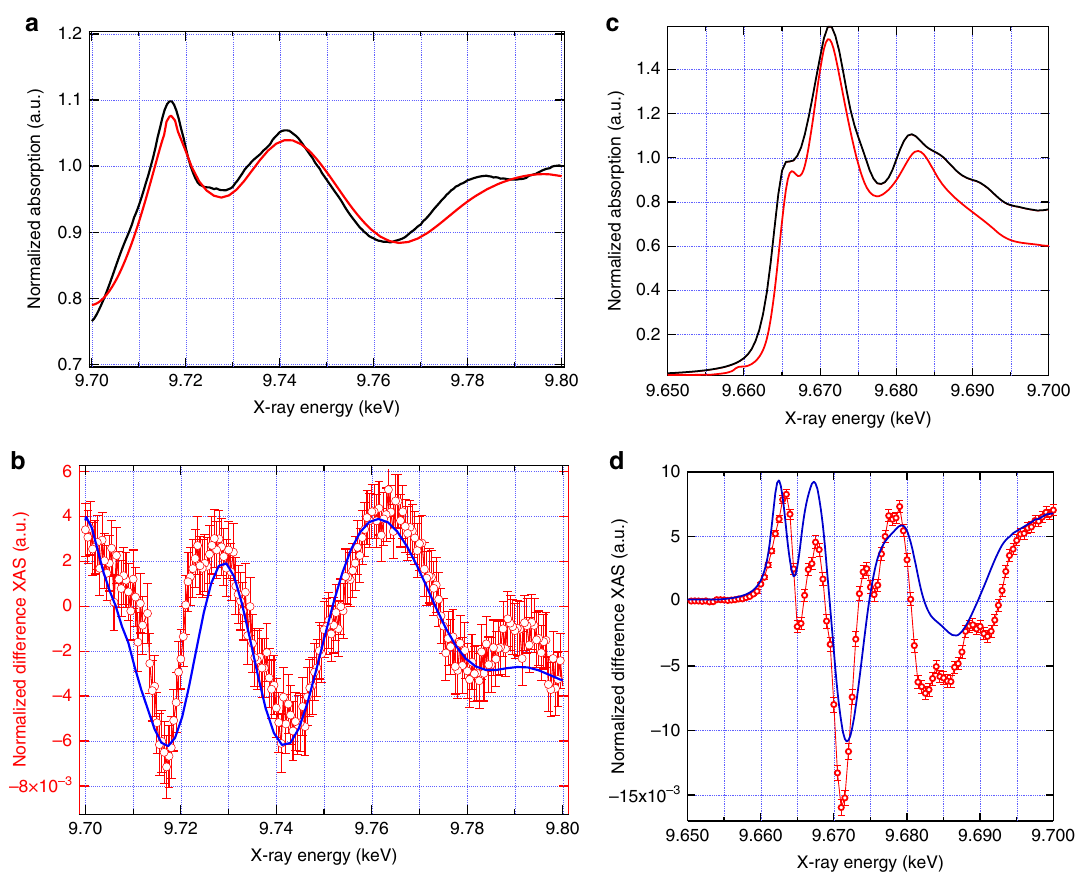
Fig. 3 Ground-state and transient XAS spectra. a Experimental (black) and simulated (red) ground-state EXAFS spectrum. b The simulated difference EXAFS spectrum (blue) assuming an excited state structure corresponding to a V 2 þ vacancy with 15% Zn – O bond distortion away from the vacancy and O 13% excitation overlaid with the experimental transient EXAFS spectrum (red) measured at 80 ps after excitation. c Experimental (black) and simulated (red) ground-state XANES spectrum. d The simulated difference XANES spectrum (blue) assuming an excited state structure identical to that simulated in ( b ) and 13% excitation shown with the experimental transient XANES spectrum (red) measured at 80 ps after excitation. Error bars shown are the standard error of the experimental